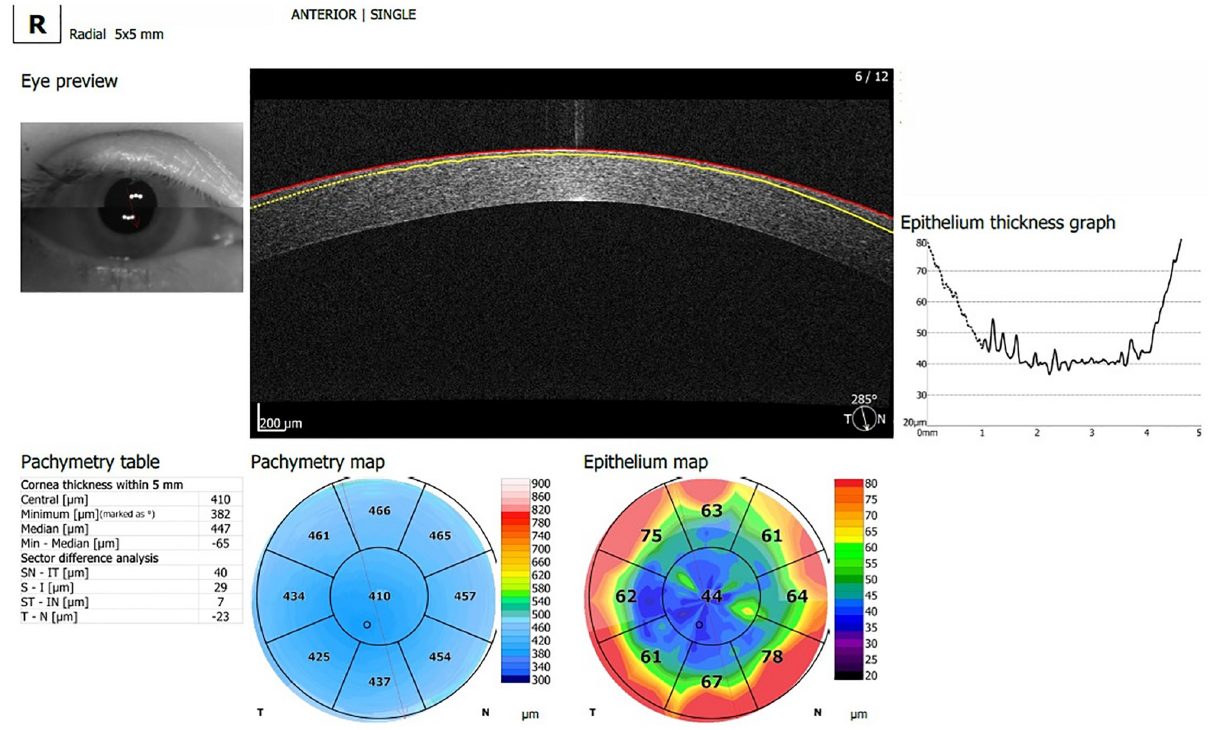
Fig 1. Corneal epithelial map produced by the REVO-NX AS-OCT.